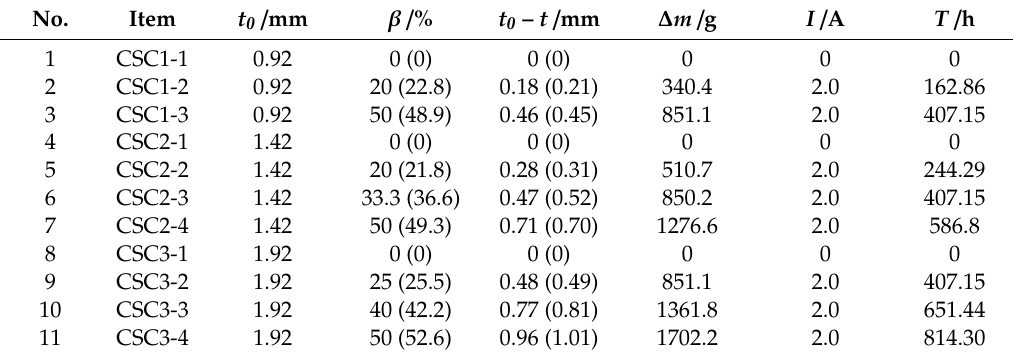
Table 1. Experimental plan of concrete-filled steel tubular (CFST) specimens’ electrochemically accelerated